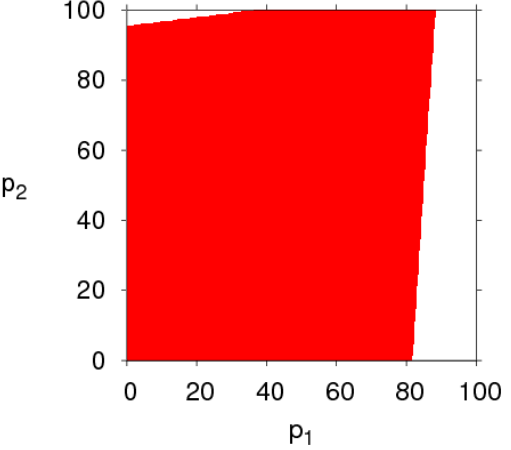
Figure 19. Basins of attraction of the dynamic system (6) when α 1 = α 2 = 0.005 and a = 400 .